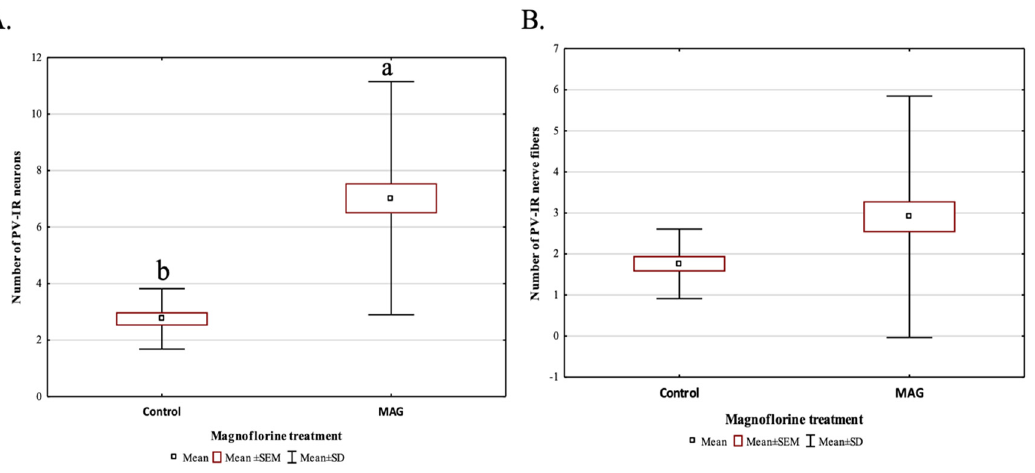
Figure 6. The average number of PV-IR neurons ( A ) and the average number of PV-IR fibers ( B ) in the mouse hippocampus treated with magnoflorine, irrespective of its dose. The data are expressed as means ± SEM (standard error of the mean; box) and standard deviation (whiskers); a, b—different letters indicate significant differences between the experimental groups at p ≤ 0.0001; n =